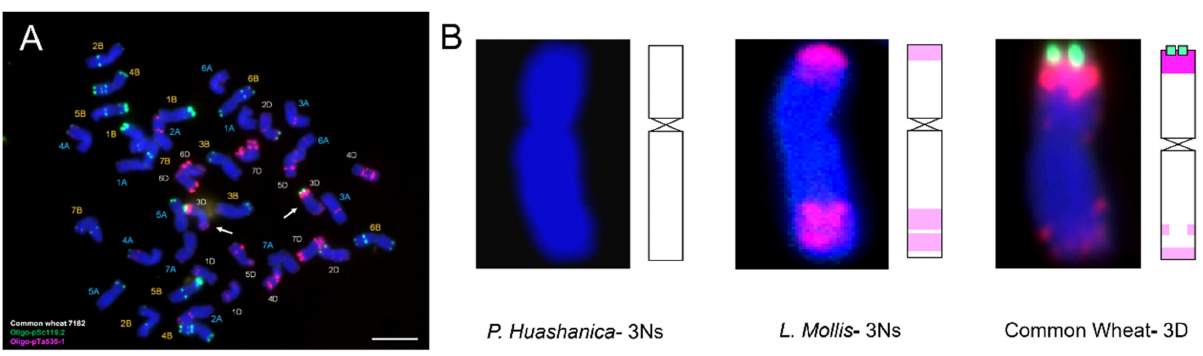
FIGURE 9 | FISH karyotype of third homoeologous chromosomes from common wheat 7182, P. huashanica , and L. mollis. (A) FISH karyotype of common wheat 7182 during metaphase and the arrows indicate the wheat 3D chromosomes. (B) FISH karyotypes and idiograms of wheat 3D, P. huashanica 3Ns, and L. mollis